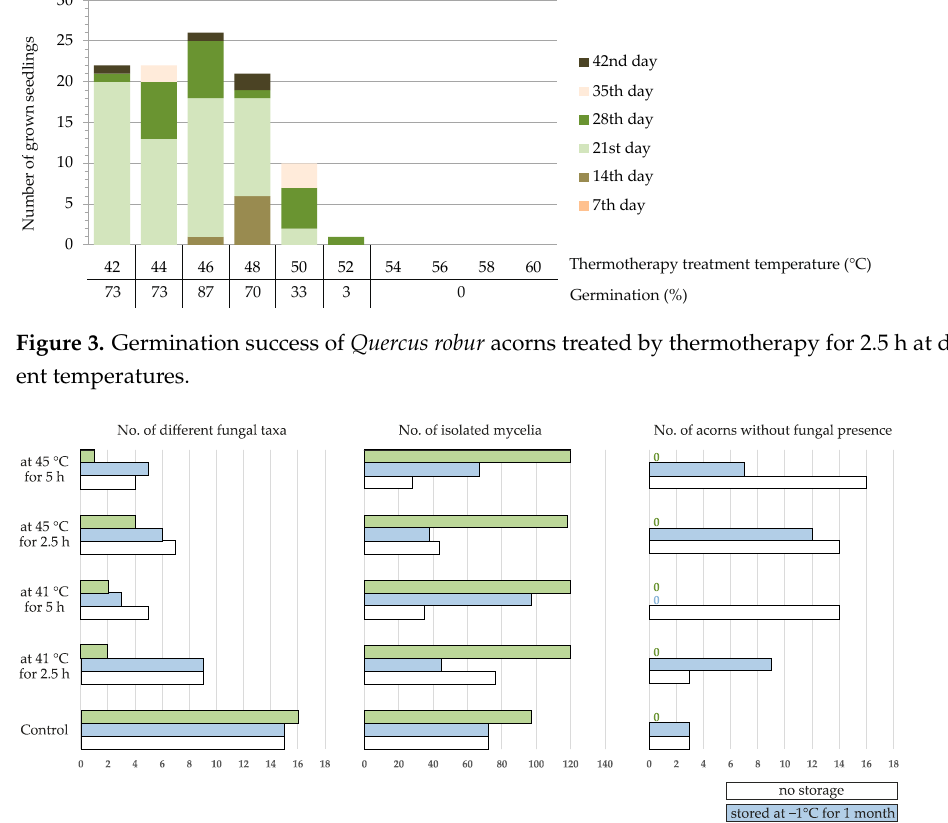
Figure 3. Germination success of Quercus robur acorns treated by thermotherapy for 2.5 h at differ- ent temperatures.